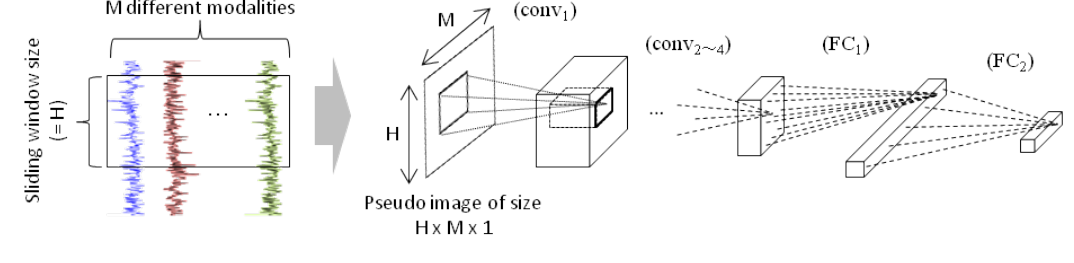
Figure 3. Architecture of time-series CNN for basic pose recognition (attribute